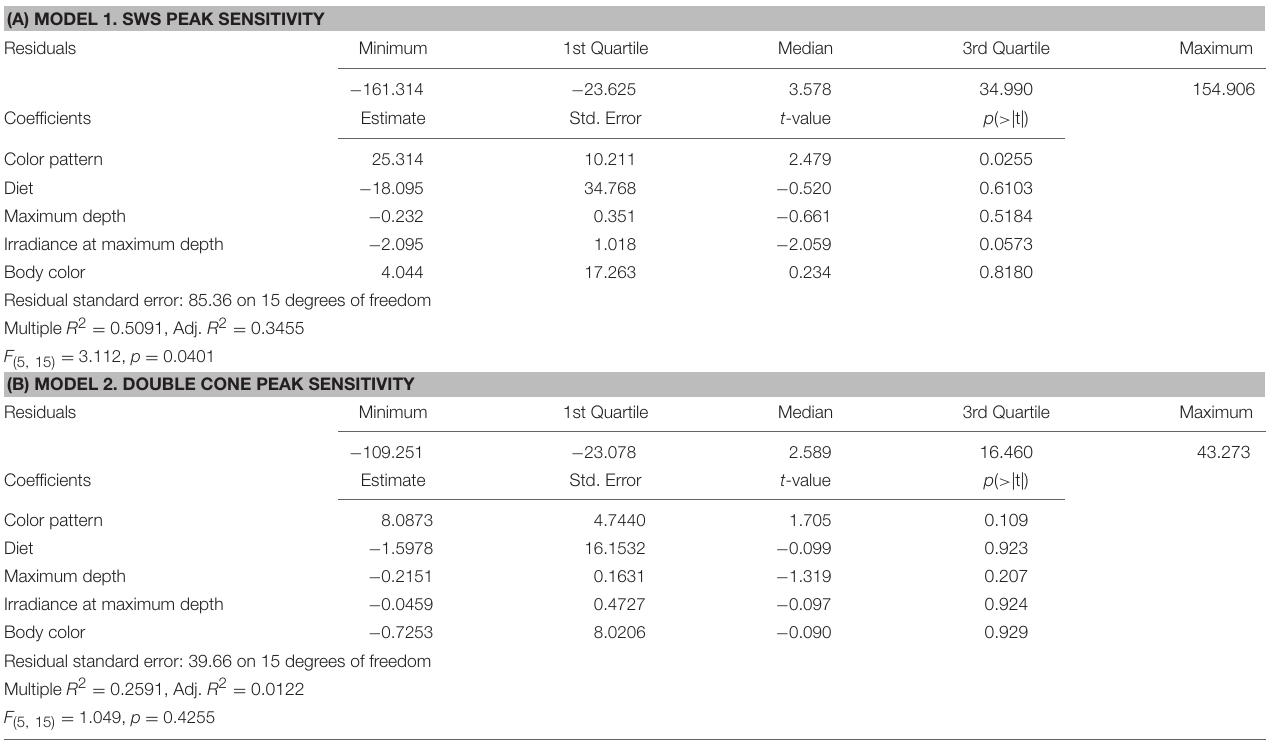
TABLE 3 | Phylogenetic Independent Contrasts performed on both (A) SWS opsin peak sensitivity and (B) double cone opsin peak sensitivity vs. environmental and color pattern characteristics.